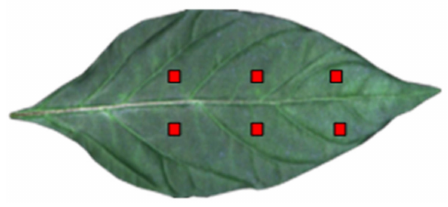
Figure 2. Sampling area of pepper